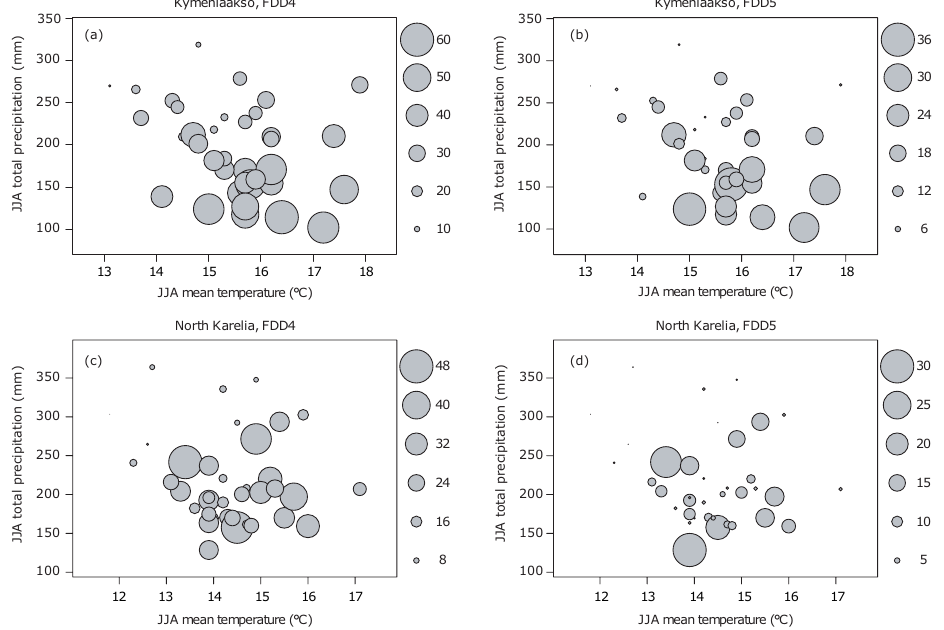
Fig. 2. Scatter plots of June–August mean temperature, June–August total precipitation and the number of the fire danger days calculated from the observed FFI in 1961–1997 in Kymenlaakso (a) for FDD4 and (b) for FDD5 and in North Karelia (c) for FDD4 and (d) for FDD5. Scales on the right side of each plot show the number of fire danger days corresponding to the size of the circles: a larger circle indicates more fire danger days.